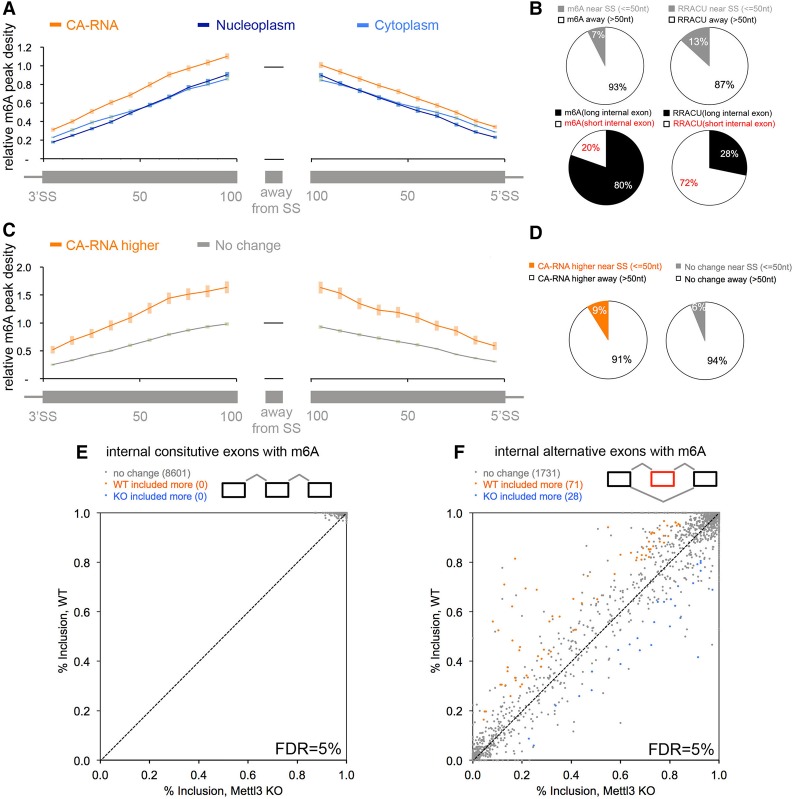
The majority of m6As is not located close to splice sites. (A) The density of m6A at increasing distances from 3′ or 5′ splice sites in CA-RNA (orange lines), the nucleoplasm (dark blue), and the cytoplasm (light blue). “Relative m6A peak density” for a fixed position from the splice site was calculated as the scaled m6A peak density at that position scaled proportional to the average m6A peak density in exonic regions >100 nt away from splice sites (black line). To clearly show the distribution of m6A peaks from the splice sites, we focused on internal exons with exon length at least 200 nt so that the 100-nt exon regions from the 5′ splice site (“SS”) and the 3′ splice site do not overlap. The internal exons 200 -nt long contain ∼80% of all internal exon m6As. The center exon is required to have m6A. Exon number = 3069. Error bar is the SEM. (B) Seven percent of exonic m6As are within 50 nt of splice sites for internal exons in A. (Top left panel) Few m6As locate close to splice sites. (Top right panel) More RRACUs locate close to splice sites. Total RRACU number is 5673 in the same exons. P < 1 × 10−24, Fisher's exact test. (Bottom left panel) Long internal exons (≥200 nt, the internal exons in A) have 80% of total internal exon m6As, while short ones (<200 nt) have only the remaining 20%. (Bottom right panel) Long internal exons have only 28% of the total internal exon RRACU motifs (total RRACU number is 46,492 for total internal exons; P < 1 × 10−100, Fisher's exact test), in contrast to short ones that have the majority (72%). Even if we consider all m6A-containing internal exons (both long and short), still, only 20% of total internal exonic m6As are within 50 nt of splice sites. (C) The CA-RNA m6A peaks that are higher showed higher density in exonic regions near 5′ or 3′ splice sites. “CA-RNA higher” refers to the m6A peaks in Figure 2A with higher m6A signal strength in CA-RNA (orange). “No change” refers to the frequency of m6A peaks with no difference between CA-RNAs and nucleoplasm RNAs in Figure 2A (gray). Error bars are SEM. (D) The majority (>90%) of transcripts in which m6As are higher in CA-RNA than nucleoplasmic RNA is at least 50 nt away from splice sites. A minority of CA-RNA transcripts does have a percentage greater density of m6A near splice sites (≤50 nt; 9% vs. 6%), but the majority of these modifications does not persist in nuceloplasmic RNA (Fig. 2A). (E) Internal constitutive exons containing m6A show no change in splicing between wild-type and Mettl3 knockout mouse ESCs. Internal constitutive exons with m6A are defined as the triexon structure, with constitutive exon being the center exon; at least one of the three exons should have m6A. All 8601 m6A-containing internal constitutive exons showed the same degree of exon inclusion in Mettl3 knockout and wild-type cells (significant changes are defined as ΔPSI [percent spiced in] ≥0.1; FDR <5%) despite a decrease in m6A level in mRNAs to 10% of wild type (Fig. 6A; Supplemental Fig. 11). (F) A minority of internal alternative cassette exons with m6A (defined as the triexon structure, with alternative cassette exon being the center exon; at least one of the three exons should have m6A) shows splicing changes in Mettl3 knockout versus wild-type cells. Approximately 5% of all 1830 m6A-containing internal alternative cassette exons changed splicing in Mettl3 knockout cells (significant changes are defined as ΔPSI ≥0.1; FDR <5%). We also examined the splicing for all constitutive exons and alternative exons regardless of whether they contain m6A or not (i.e., even considering the indirect effects of m6A on splicing). Again, all 67,706 constitutive exons spliced identically, and only a very minor proportion (∼3%) of all 11,715 alternative cassette exons changed splicing. Other alternative splicing types showed even fewer changes, including alternative 5′ splice site, alternative 3′ splice site, and intron retention. We also analyzed the raw RNA-seq data of previous publications that reported certain splicing changes upon comprising Mettl3 expression levels (Supplemental Fig. 9; Dominissini et al. 2012; Zhao et al. 2014; Geula et al. 2015; Liu et al. 2015) and found the same result: that exons splice mostly the same when their exonic m6As were lost.